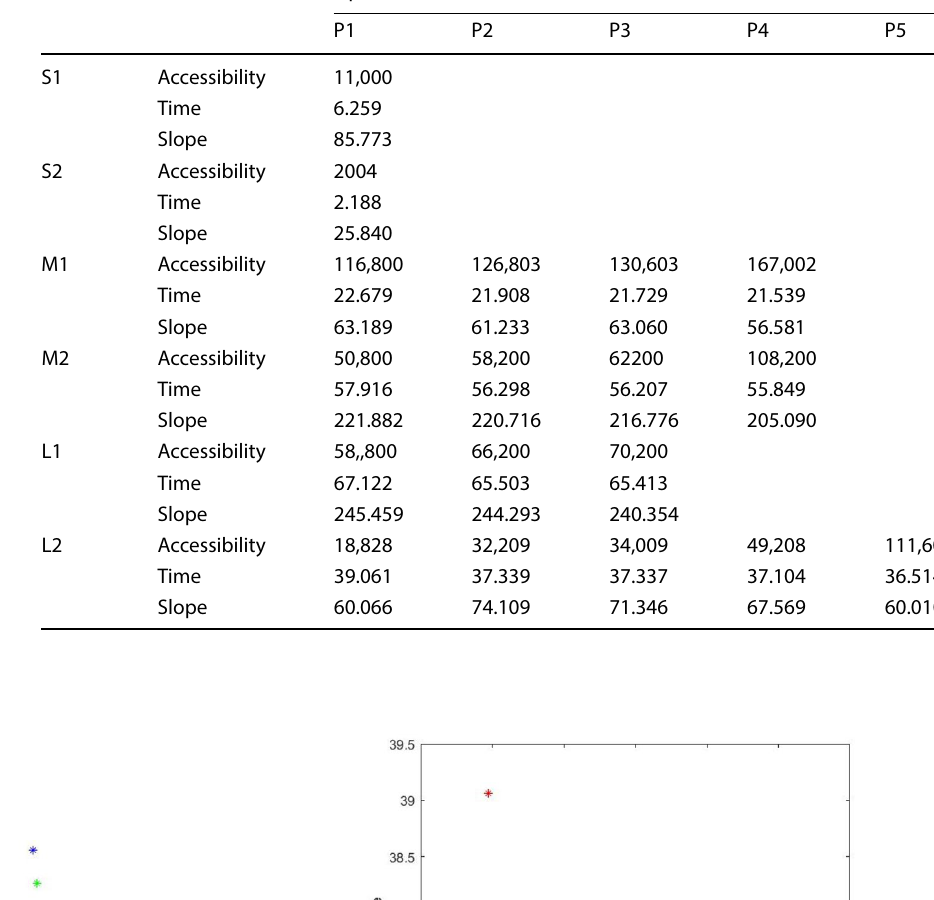
Table 7 Obtained results with three criteria